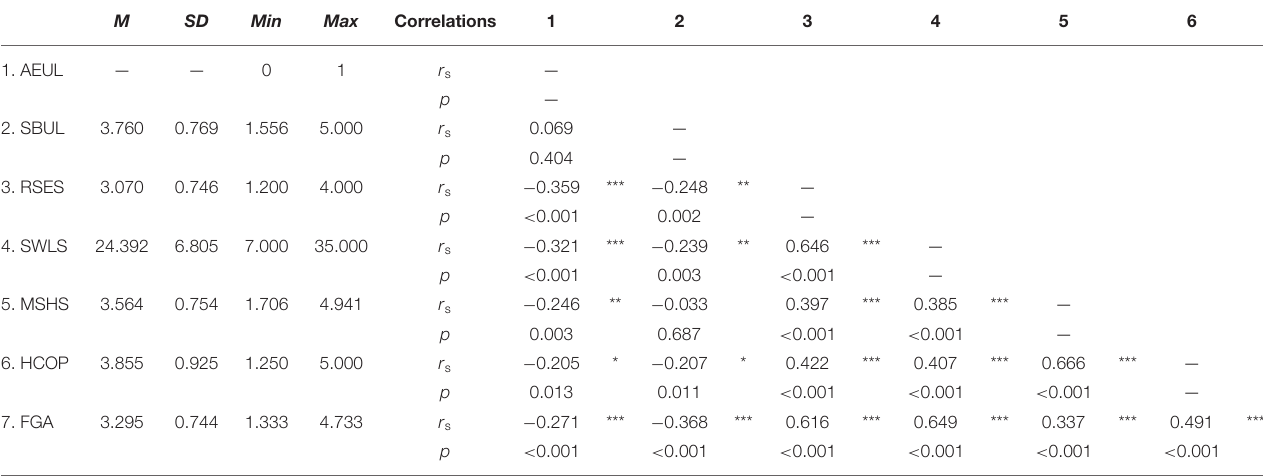
TABLE 1 | Means, standard deviations, minimum, maximum, and bivariate correlations of main study variables. M SD